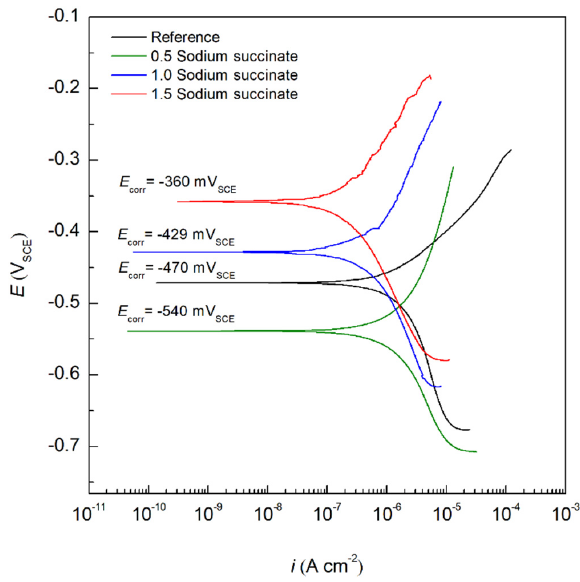
Figure 10. PDP curves of carbon steel submerged in 0.6 M Cl − SCPS in the absence and presence of specific concentrations of sodium succinate at 25 °C.